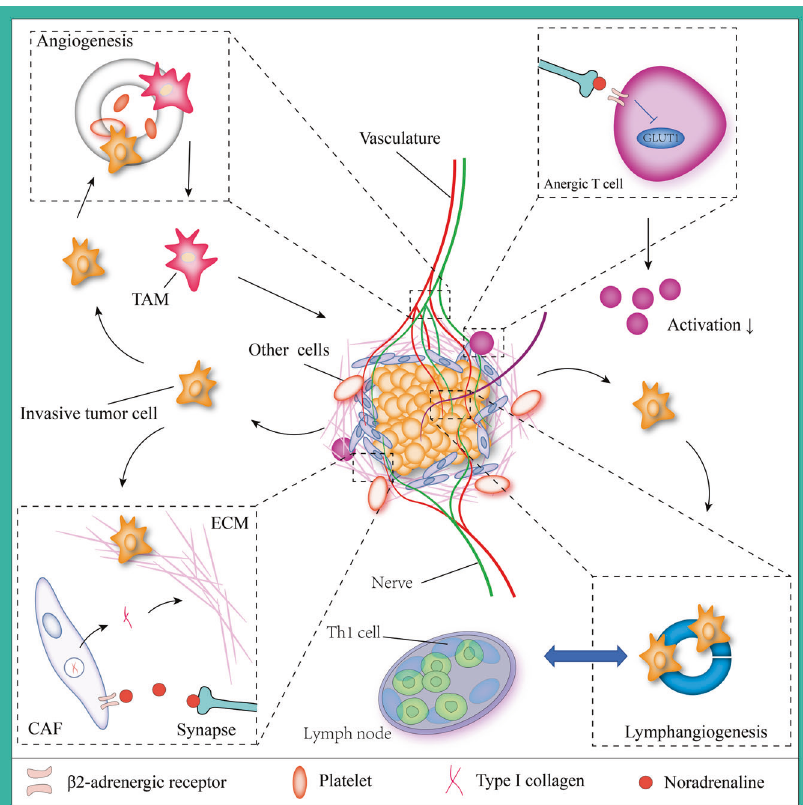
Fig. 2 Nerve cells drive tumor progression and extracellular matrix (ECM) remodeling. Nerves interact with multiple stromal and malignant components that promote tumor growth and dissemination during tumor development. Signaling from adrenergic nerves stimulates angiogenesis and lymphangiogenesis and activates tumor metastatic pathways. This signaling also activates T cells by inhibiting glucose transporter (GLUT1) expression, which in turn results in a decrease in metabolic activation. In addition, adrenergic nerves help in maintaining the immunosuppressive microenvironment by recruiting T helper 1 cells (Th1 cells) to tumors. Noradrenaline (NA) induce cancer-associated fi broblasts (CAFs) to produce type I collagen that remodel